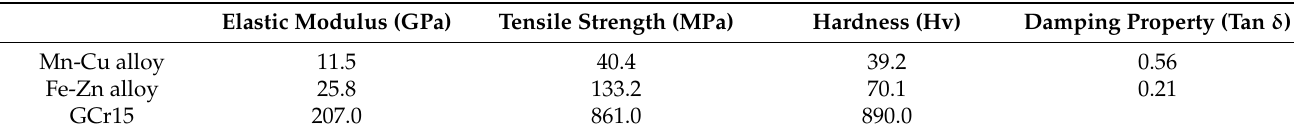
Table 1. The mechanical properties of frictional